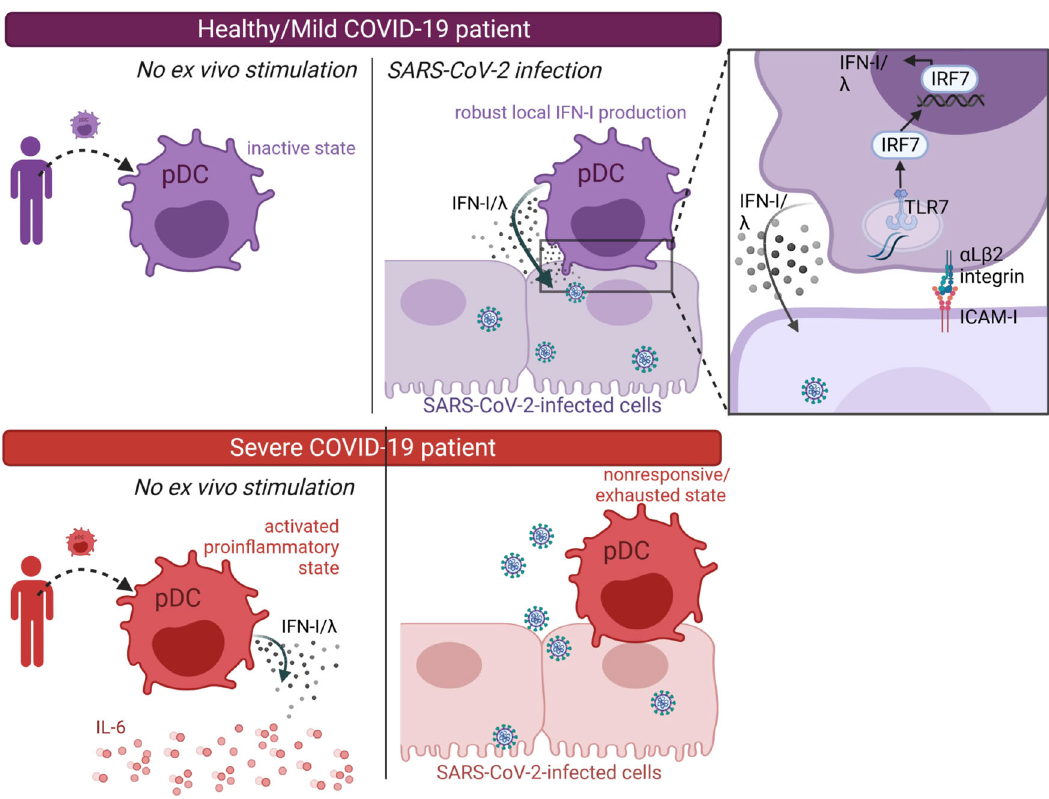
Fig. 6 | Proposed model of the innate responses associated with COVID-19 severity. Our longitudinal study of the innate responses by ex-vivo stimulation of PBMCs from COVID-19 patients, and across distinct disease severities (i.e., mild/ asymptomatic versus severe COVID-19 and healthy donors, as reference) high- lightedthefollowingproposedmodel.pDCsfrommild/asymptomaticpatientsand healthy donors (in purple) robustly produce IFN-I/ λ upon cell contact with SARS- CoV-2-infected cells(upper panel).Asopposed,pDCs from severe patients (in red) produceIFN-I/ λ inabsenceofexvivostimulation,butfailtobeactivatedbycontact with SARS-CoV-2-infected cells (lower panel). This non-responsive/exhaustedstate